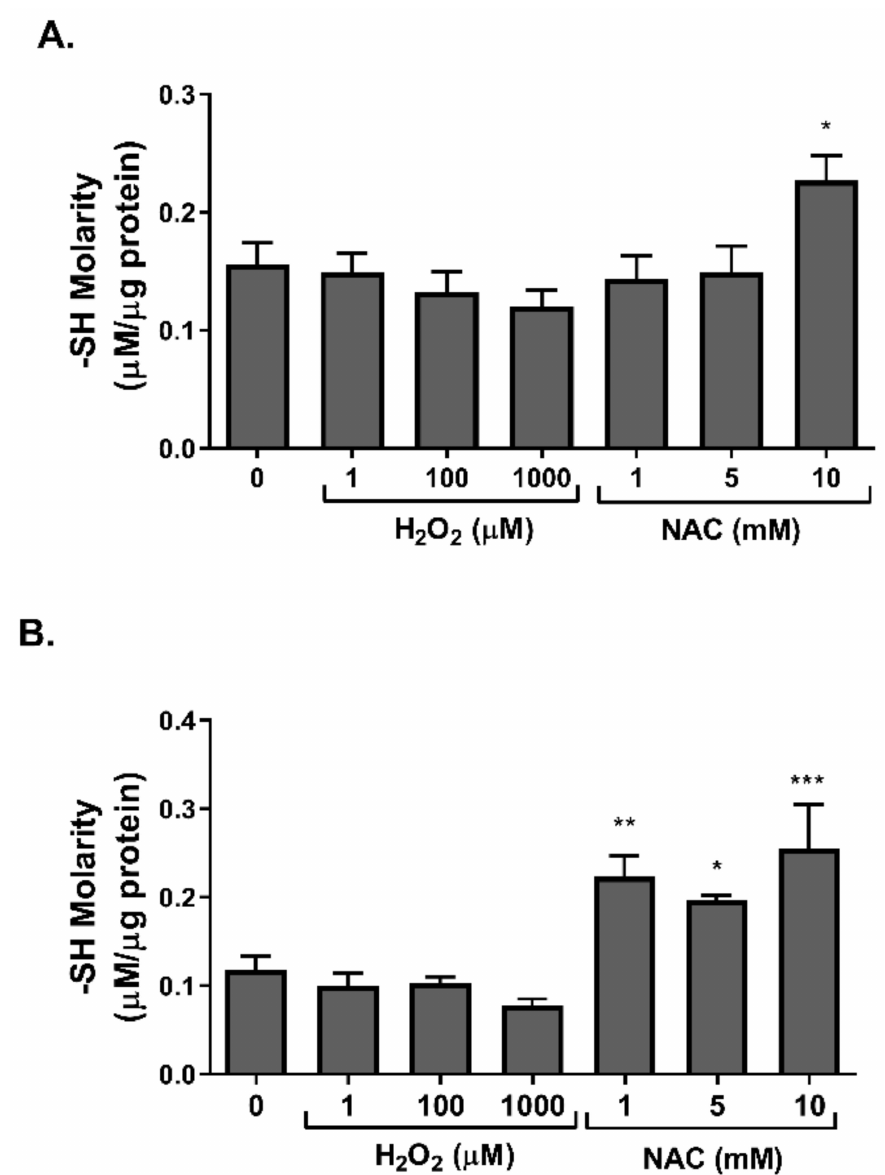
Figure 7. NAC increased the level of free thiol residues in 3T3-L1 and L6 cells. 3T3-L1 adipocytes ( A ) and L6 myotubes ( B ) were treated with H 2 O 2 or NAC for 24 h. Free thiol (SH) level was measured according to Elmann’s assay, as described in Methods. The data represent the mean ± SEM of 5 independent experiments. * p < 0.05, ** p < 0.005 and *** p < 0.0005, compared to control, analyzed by one-way ANOVA, followed by Dunnett’s post hoc